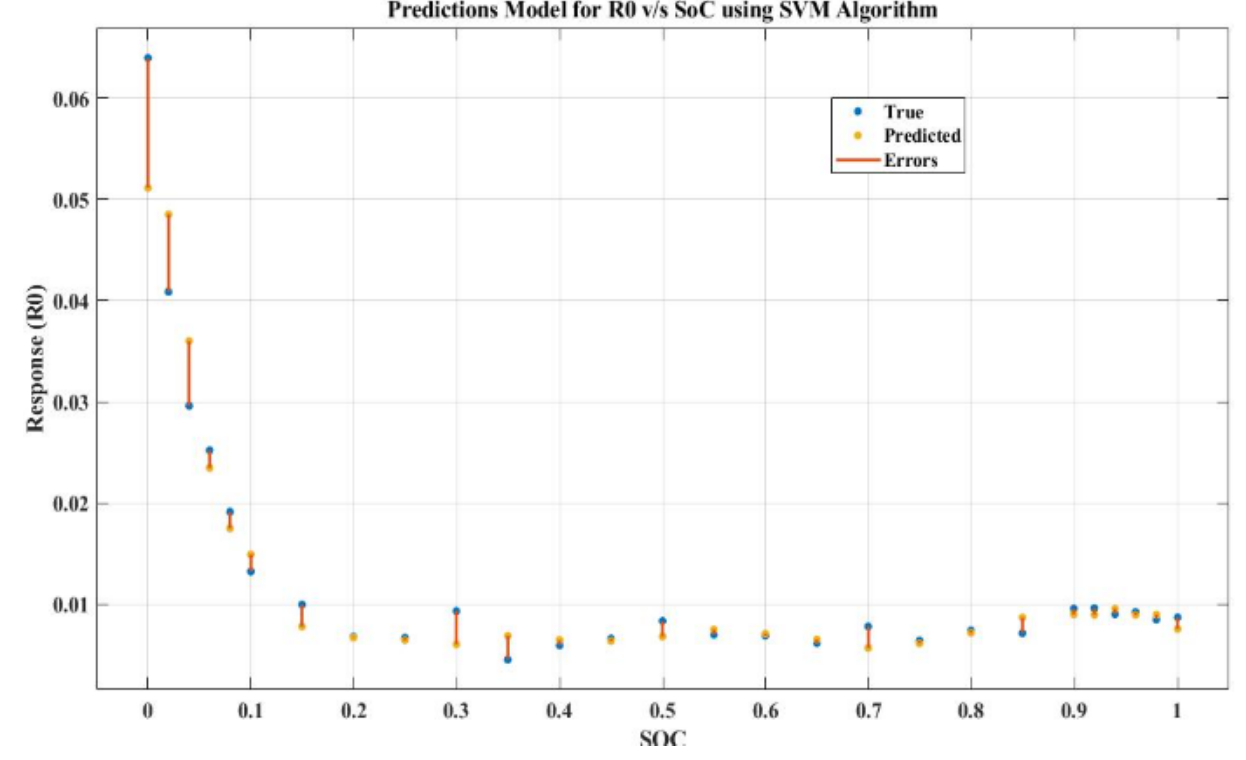
Figure 20. Prediction model for parameter estimation: C 1 vs. SOC.